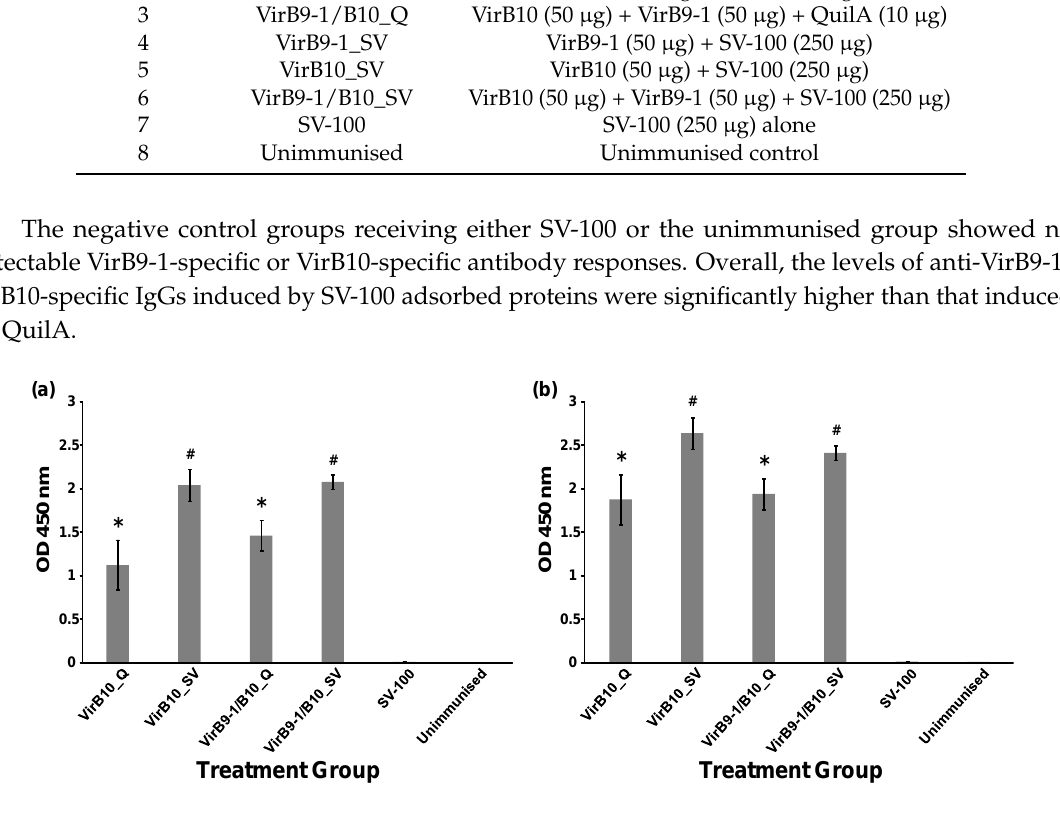
Figure 6. The SV-100 silica vesicles act as a self-adjuvanting antigen carrier and induce potent and